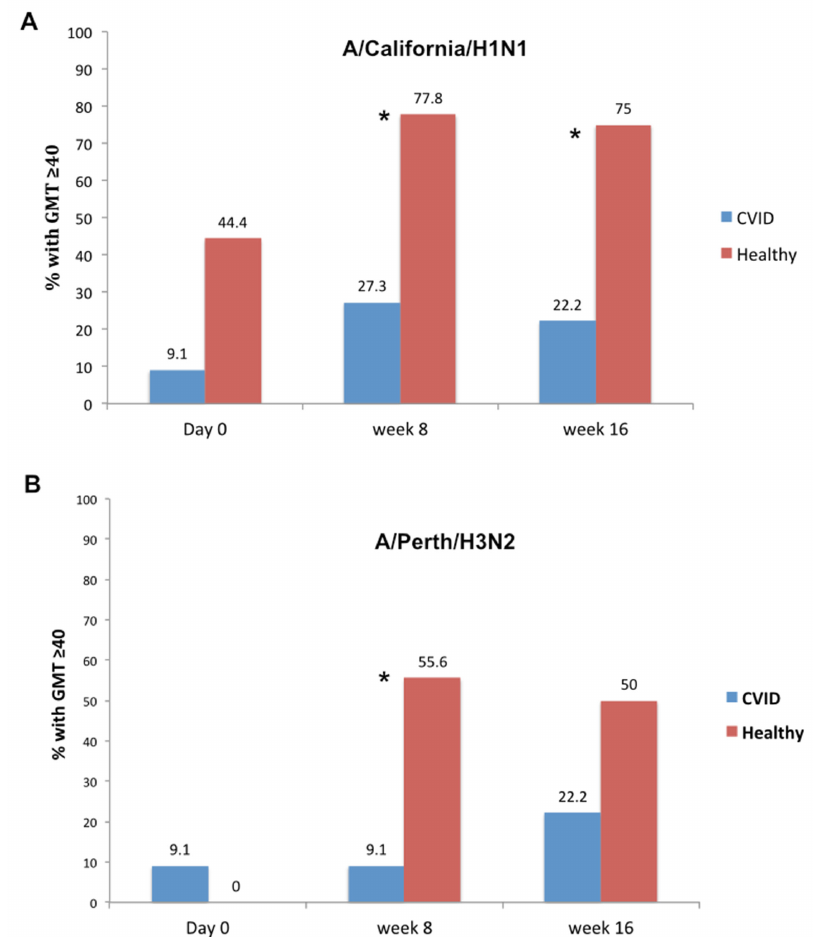
Figure 3. Percentage of patients with CVID and healthy controls with a titer ≥ 40 at baseline (time 0), 6, and 12 weeks post-vaccination. Shown are CVID (blue bars) and healthy control groups (orange bars) and various time points. *= P <0.05 between CVID and healthy group at that time point, using Pearson Chi-squared